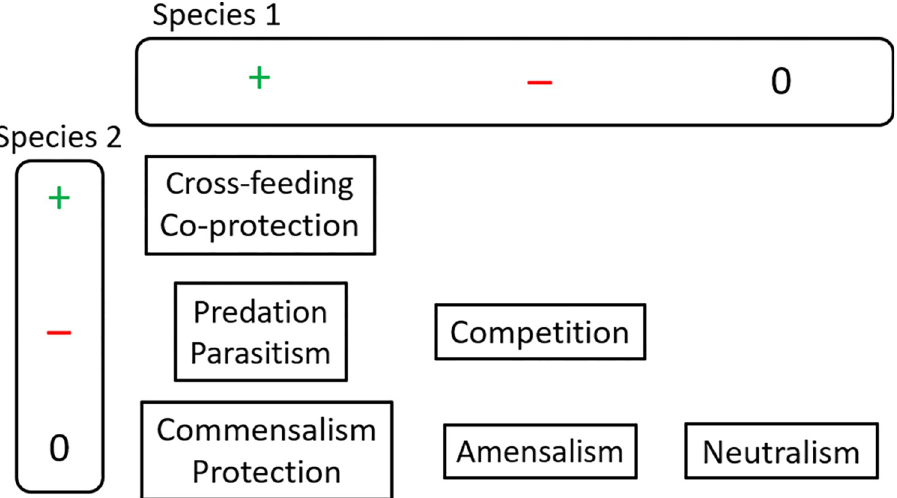
Fig 1. Classification of eco-interactions between species. Cross-feeding (or syntrophy) and co-protection (or symprostasy ) are two specific eco-interactions belonging to mutualism (positive effect for both interacting